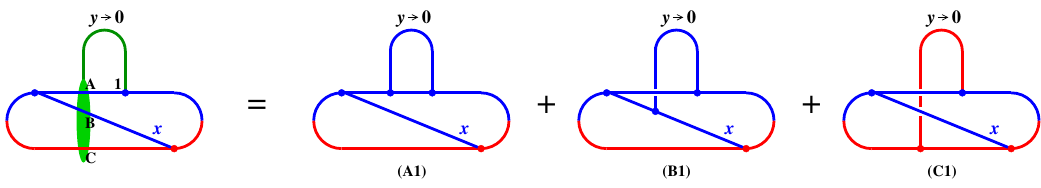
0 behaviors cancel in the small- y limit. !